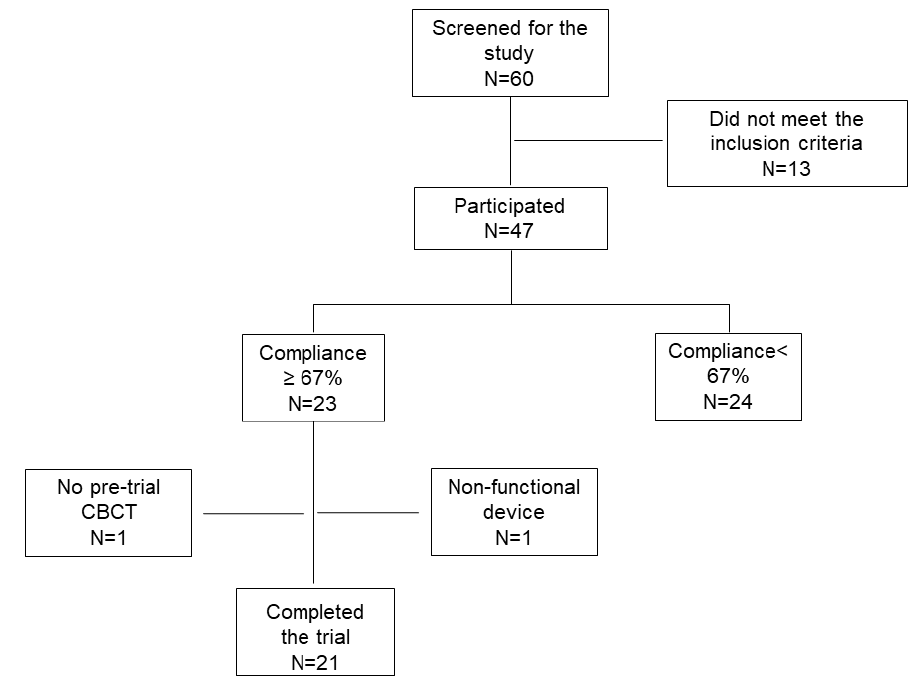
Figure 1. The CONSORT flow diagram.